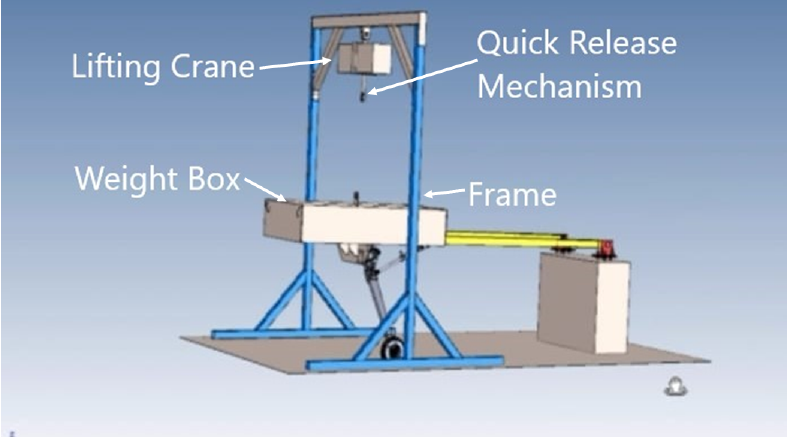
Figure 12. Conceptual design of drop test rig for product-based qualification of main landing gear struts of the given